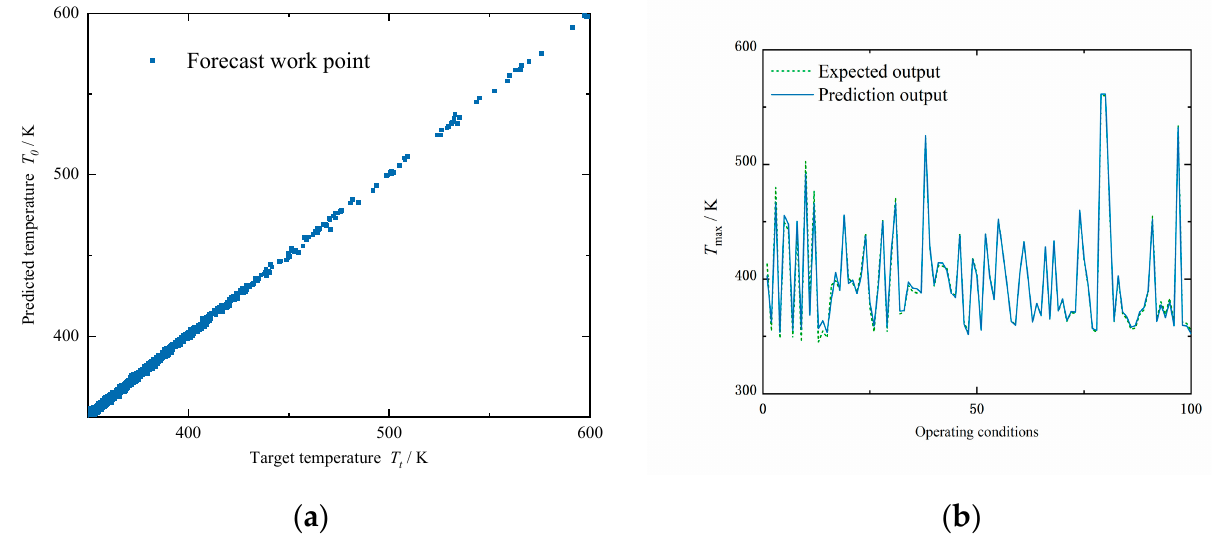
Figure 8. ( a ) Fitting diagram of BP neural network training results; ( b ) prediction output of BP neural network.